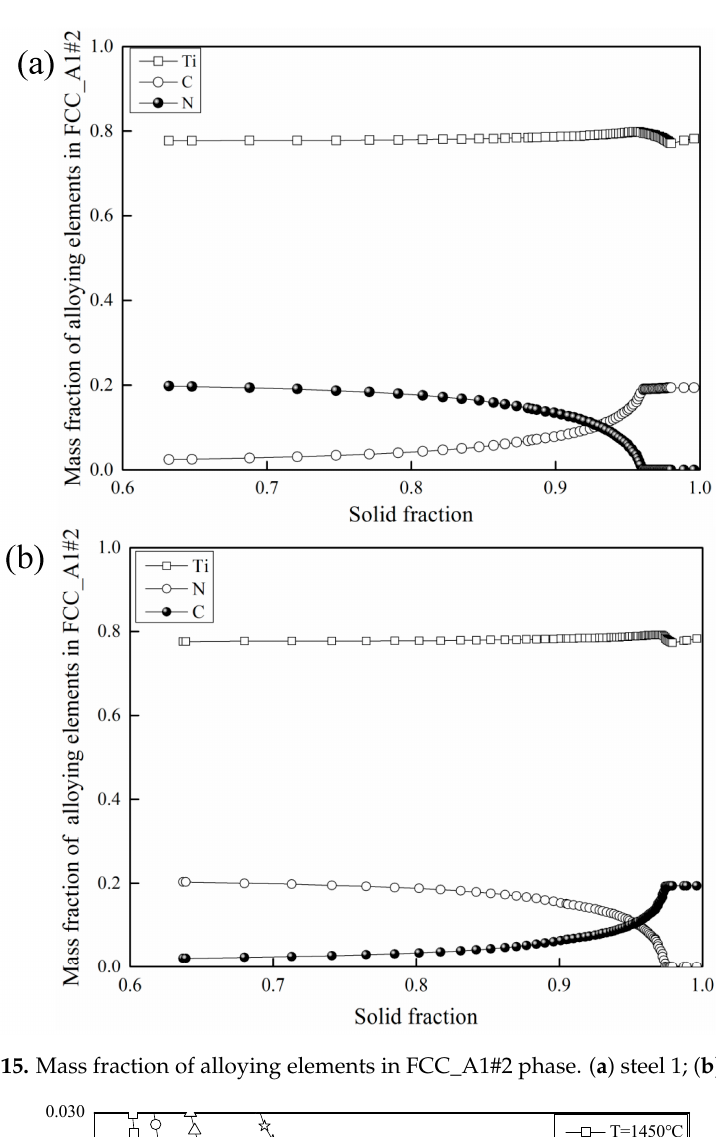
Figure 15. Mass fraction of alloying elements in FCC_A1#2 phase. ( a ) steel 1; ( b ) steel 2.